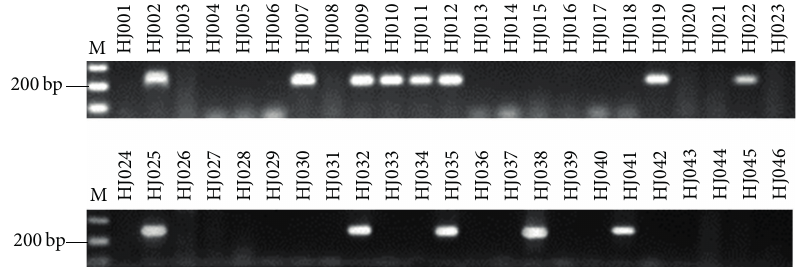
Figure 8: Amplification of S-RNase alleles in 46 progenies of “Hongpisu” × “Jinhua” with S26PF2 and S26PR2 primers. M: 100 bp DNA ladder; lanes 1 to 46 correspond to the progeny